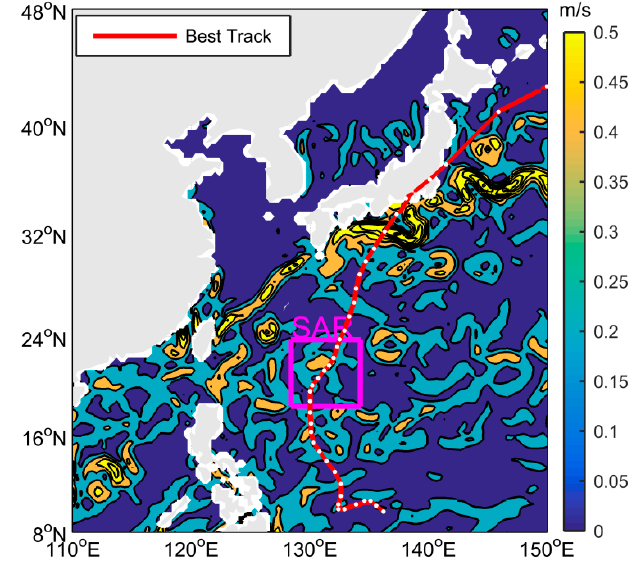
Figure 1. The dual-polarized SAR (synthetic aperture radar) image position and the best track for Typhoon Lan (2017). The background displays the OSCAR current speeds.